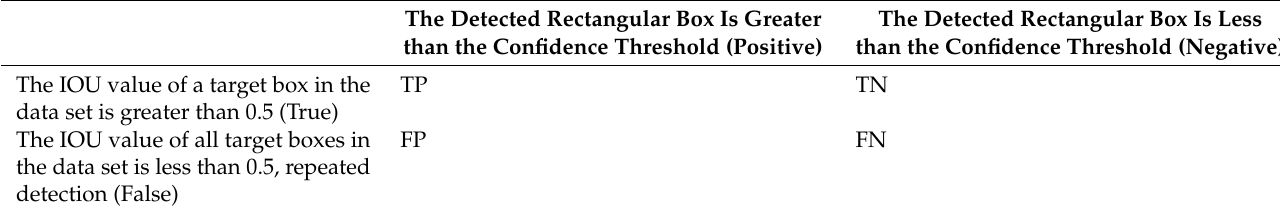
Table 1. Meanings of TP, FP, TN and FN in target detection.